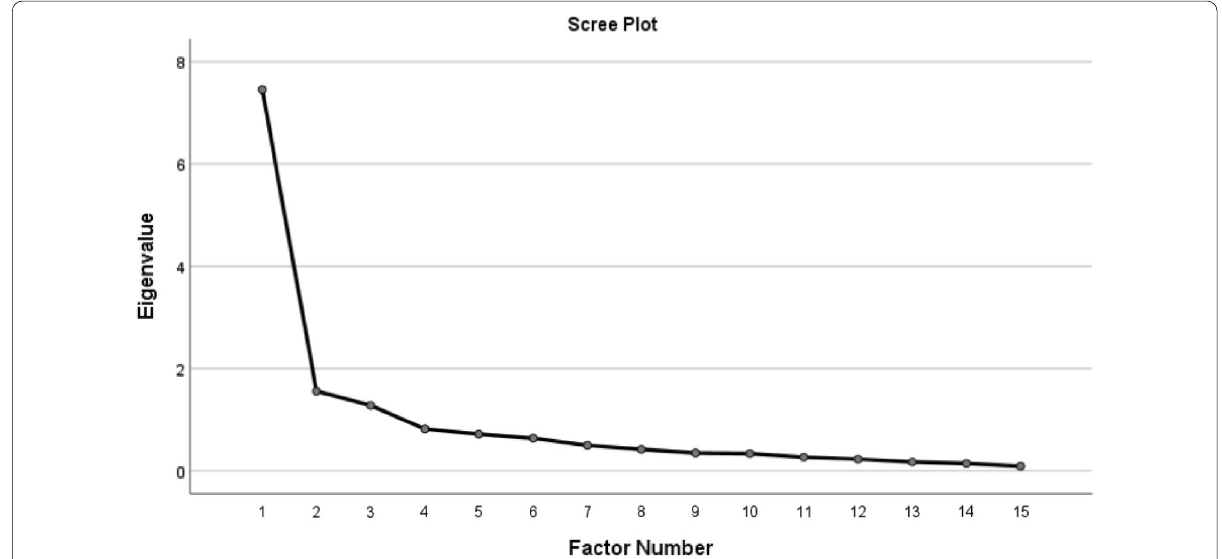
Fig. 1 Scree plot for the EFA of the QoR-15 questionnaire